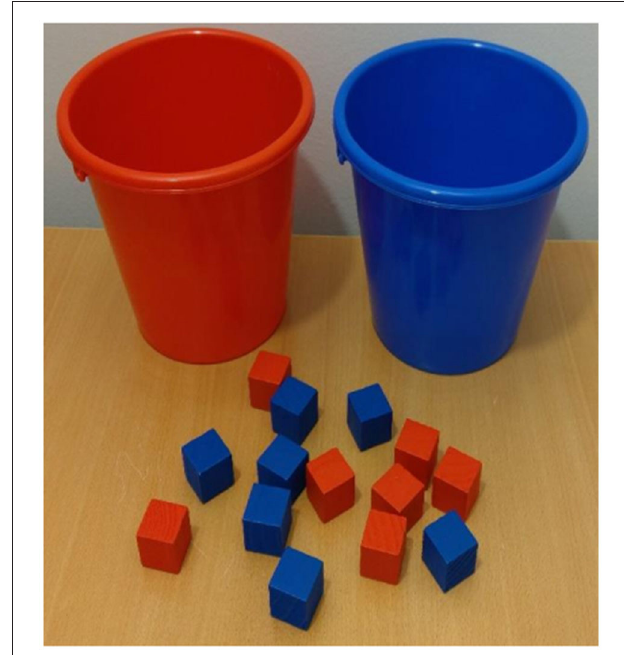
FIGURE 1 | Materials for the Reverse Categorization task.